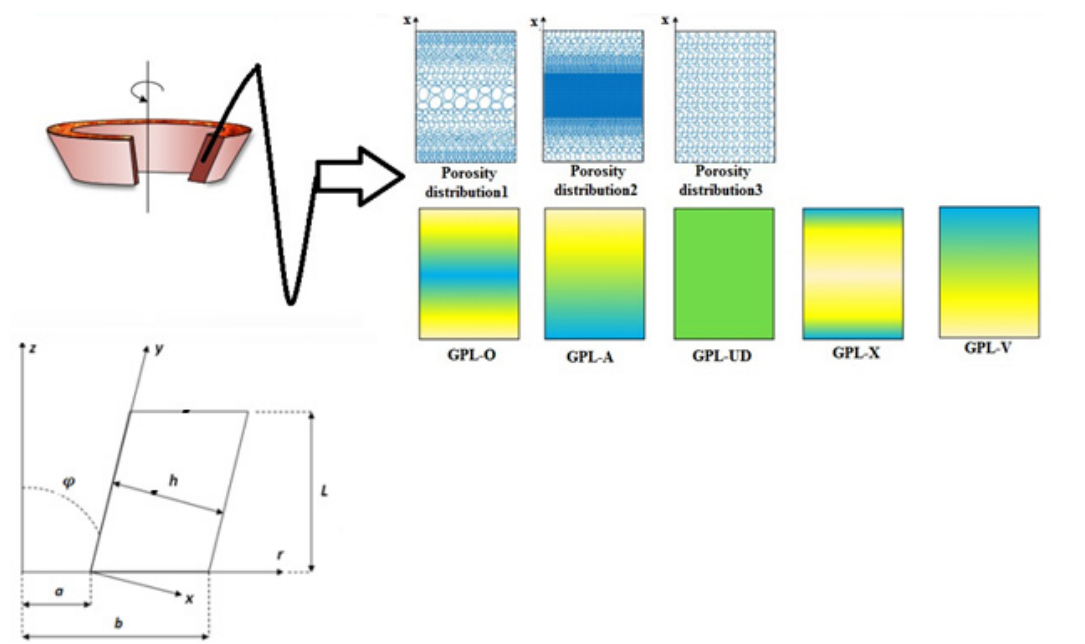
Figure 1. Geometry of rotating truncated cone for various porosity and GPL patterns across the x axis (thickness direction).